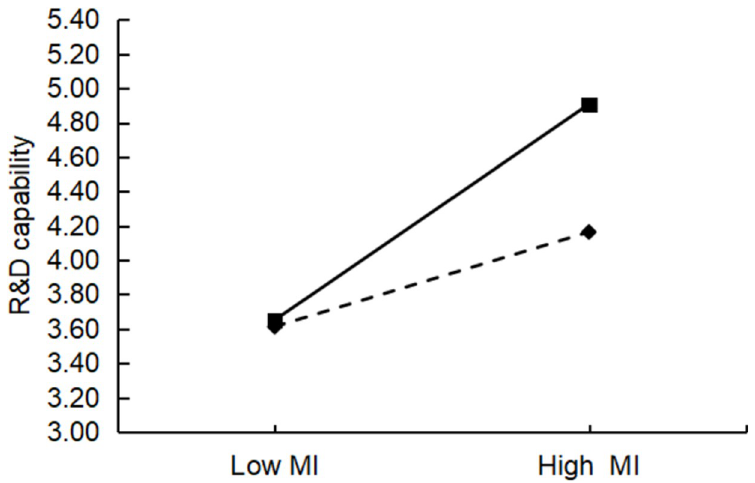
Fig 4. Test of the moderating effect of absorptive capacity differences on management interaction and R&D capabilities.